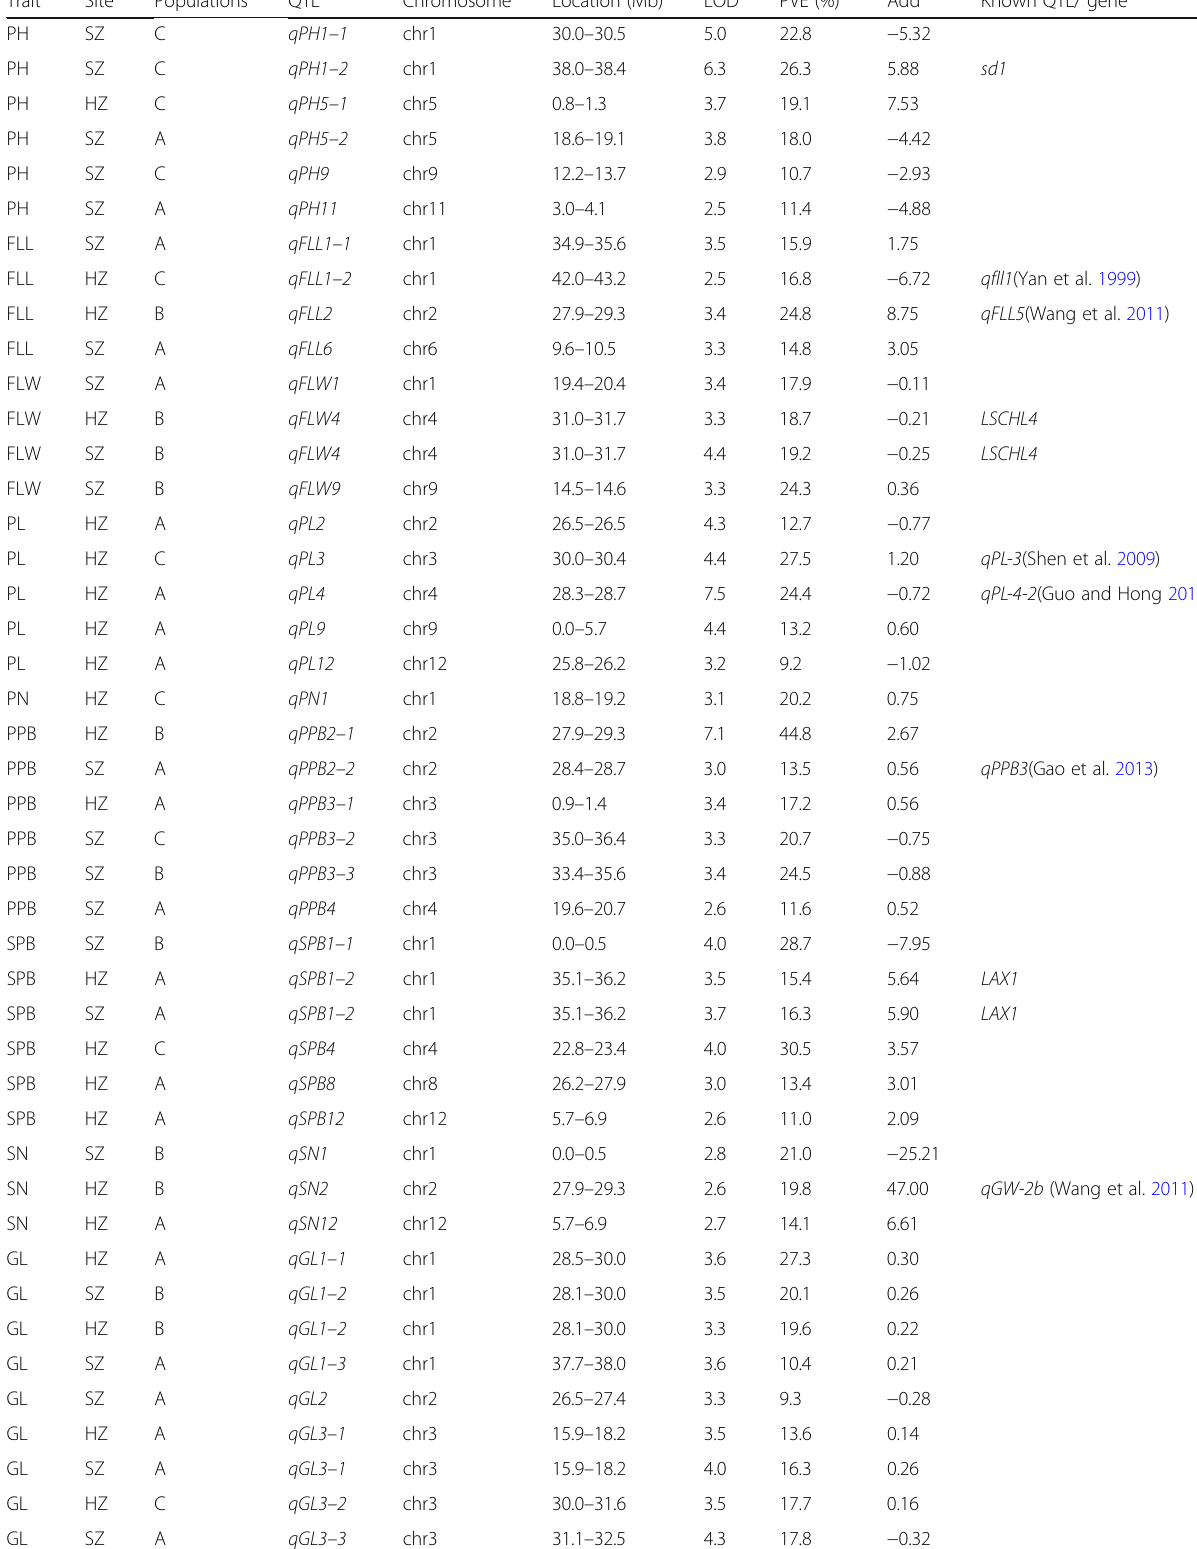
Table 2 QTLs for 11 traits detected in 3 sets of CSSLs in Shenzhen (SZ) and Hangzhou (HZ) Trait